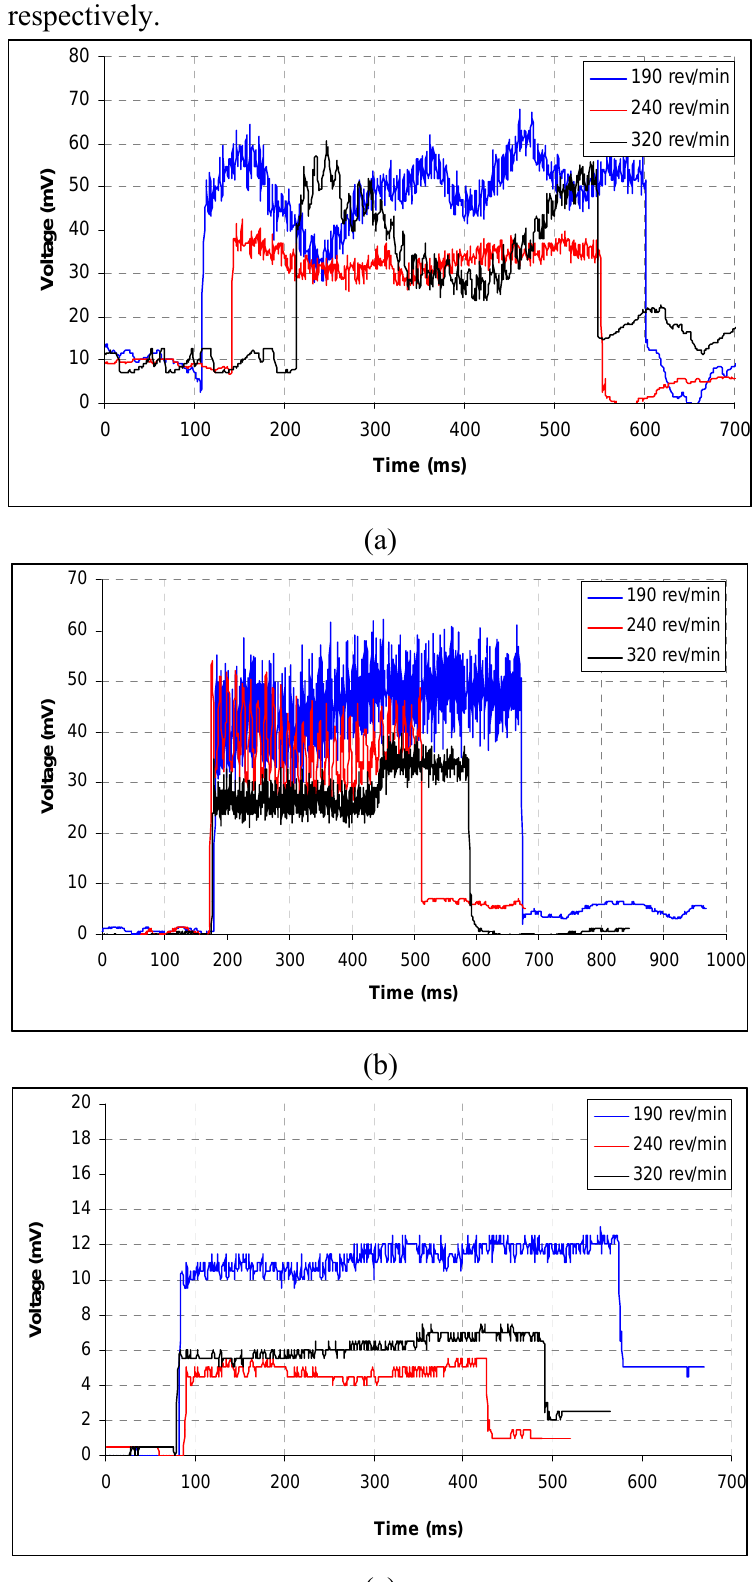
Figure 6 . Comparison of cutting forces at different rotational speeds at a feed speed of 0.081 mm rev -1 for TiN-coated cutting tools: (a) cutting force: y = -0.501 x + 1.0698 ( R 2 = 0.9998; P < 0.001), (b) feed force: y = 80.26 x + 124.9 ( R 2 = 0.9995; P < 0.001) and (c) radial force: y = 7.94 x + 128.5 ( R 2 = 0.9993; P < 0.001). y and x values are in kN and in mV,